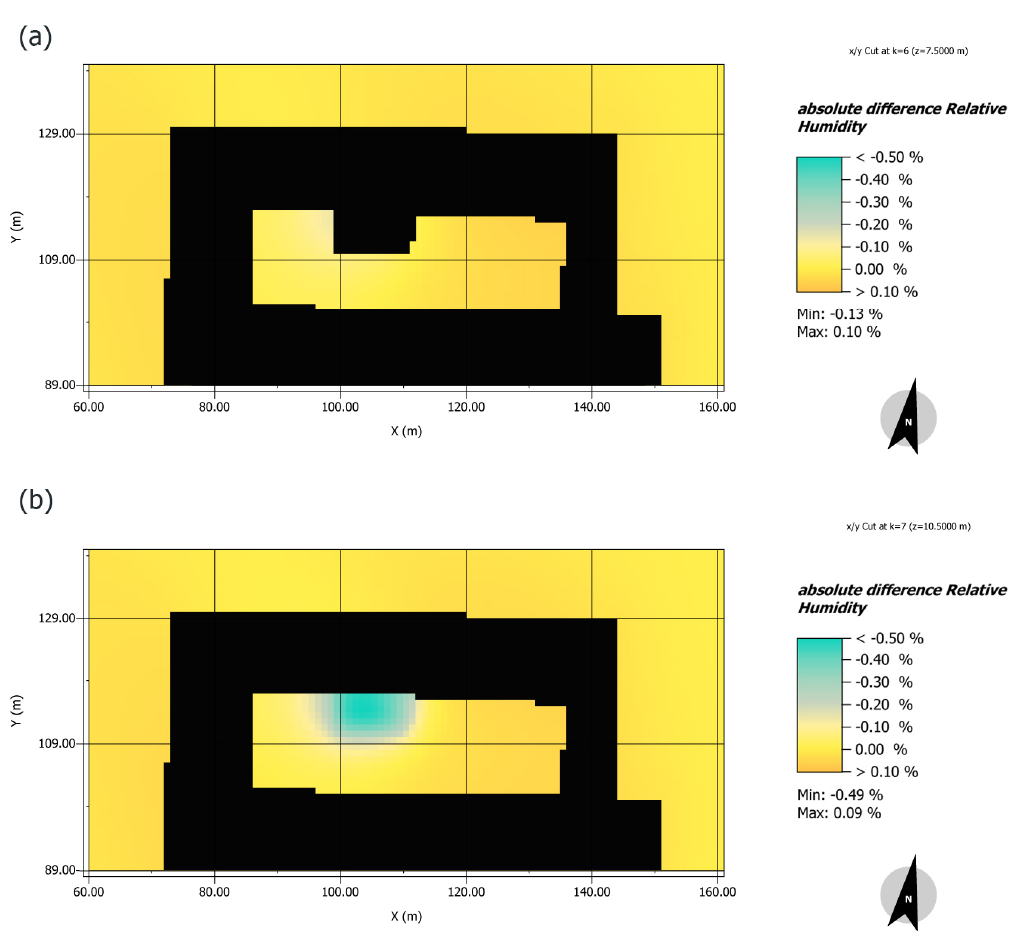
Figure 18. The comparison of initial state with reference green roof relative humidity in horizontal cross sections at the height of 7.5 m ( a ) and 10.5 m ( b ). Figure by authors.